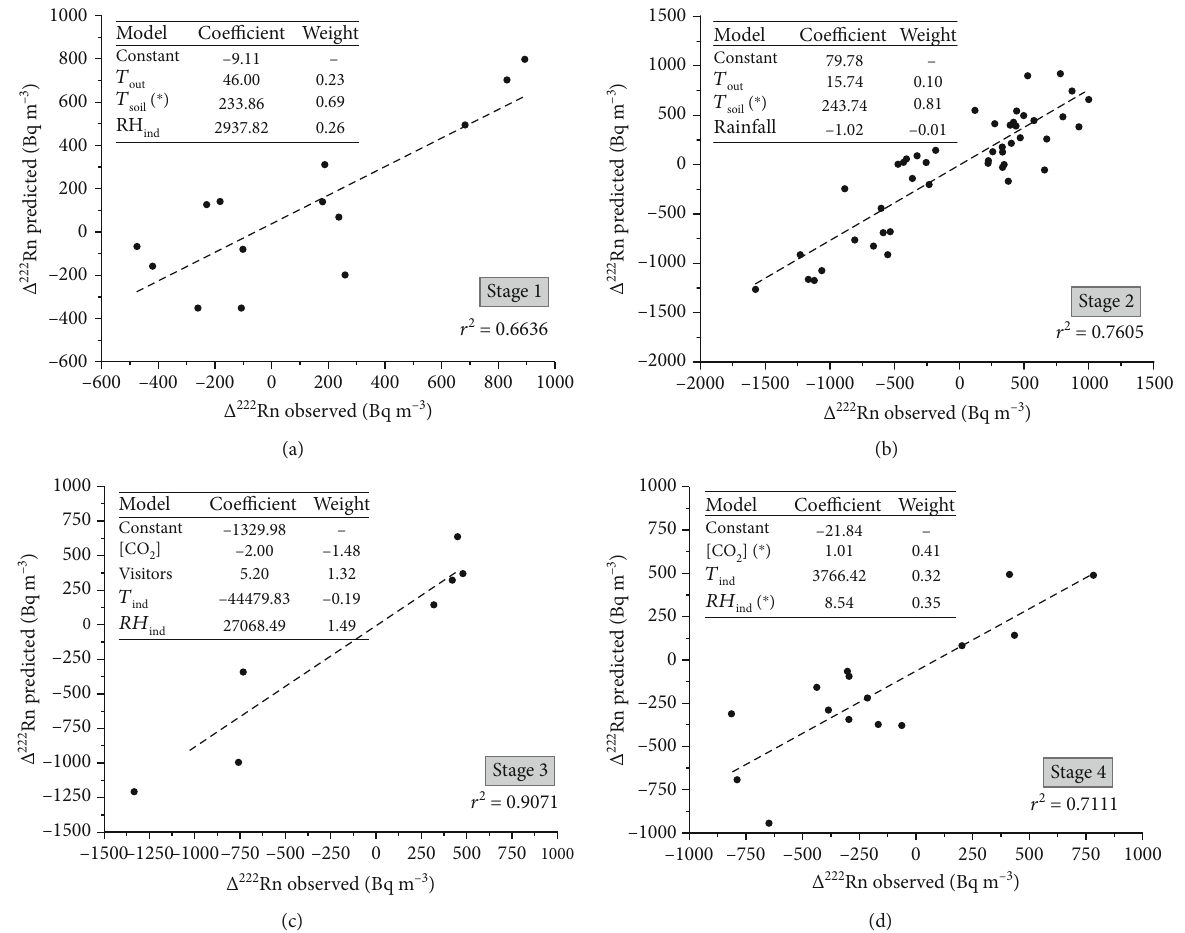
Figure 5: Observed and predicted values of 222 Rn increments considered for the di ff erent cave stages: (a) stage 1 (gaseous recharge), (b) stage 2 (maximum gas concentration in the cave), (c) stage 3 (gaseous discharge), and (d) stage 4 (minimum gas concentration in the cave). Predicted values are obtained in each case considering the predictor variables established in the PCA (Table 1). The unstandardized coe ffi cient (coe ffi cient) of each predictor variable within the multivariate analysis as well as its weight (standardized coe ffi cient) is shown for each individual prediction. ∗ indicates signi fi cant variables in the multivariate